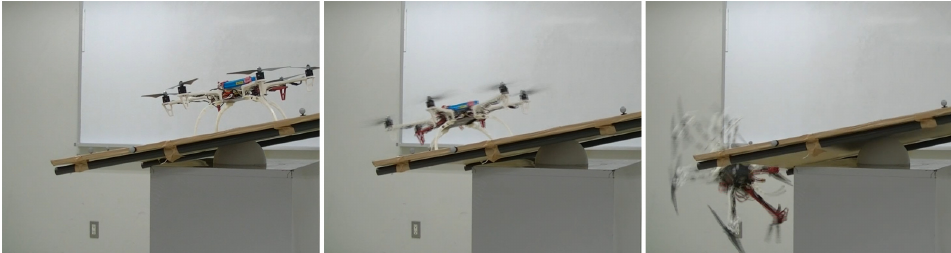
Figure 8. Conventional UAV take-off from a sloped surface resulting in sliding and falling down.